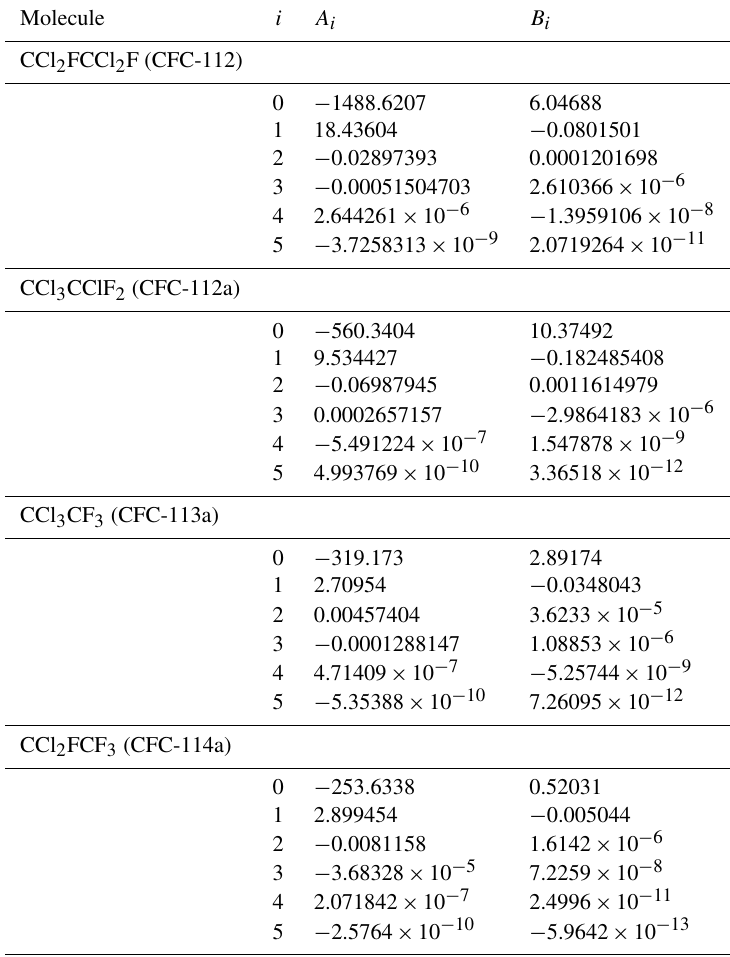
Table 3. Parameterization of the UV absorption spectra for CCl 2 FCCl 2 F (CFC-112), CCl 3 CClF 2 (CFC-112a), CCl 3 CF 3 (CFC-113a), and CCl 2 FCF 3 (CFC-114a) obtained in this work. The parameterization is for wavelengths 192.5–235nm and temperatures 230–323K for CFC- 112 and CFC-112a and 207–323K for CFC-113a and CFC-114a. Units: σ(λ,T ) (cm 2 molecule − 1 , base e), λ (nm), and T (K) ln (σ (λ,T )) = P A i λ ii + (T − 296 ) P B i λ ii i i